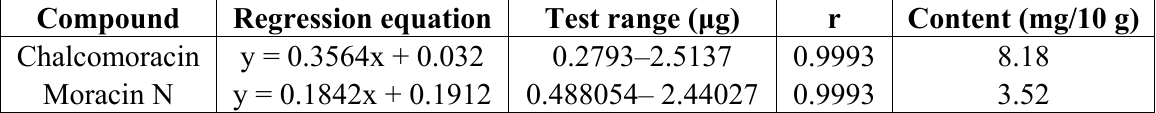
Table 1. The results of semi-quantitive detection of chalcomoracin and moracin